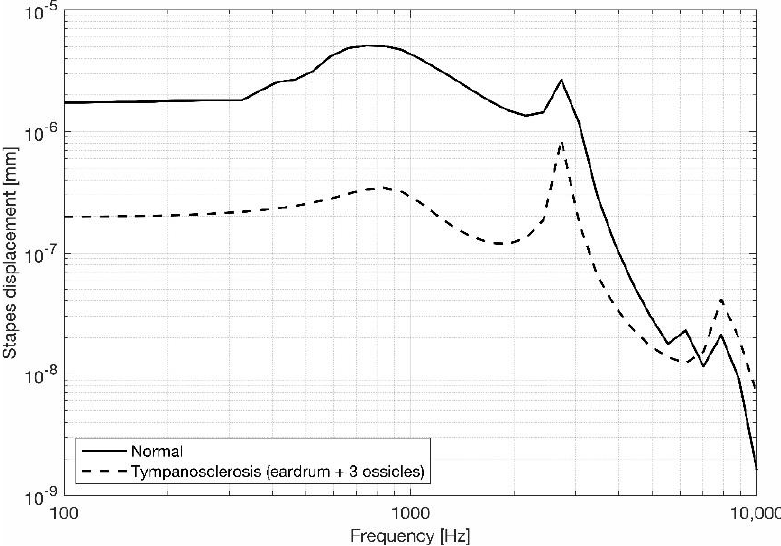
Figure 10. Stapes footplate displacements’ magnitude, comparing the model that was representative of a normal ear and tympanosclerosis affecting the eardrum and the three